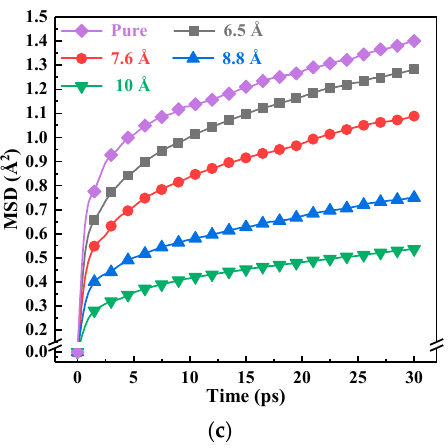
Figure 5. The variation of Mean Squared Displacement ( MSD ) values with time. ( a ) MSD values of the 6.5 Å system at 300 K with different crosslinking densities; ( b ) MSD values of the 67% crosslinking density system with 6.5 Å particle sizes at different temperatures; ( c ) MSD values of the 67% crosslinking density system at 300 K with different particle sizes.